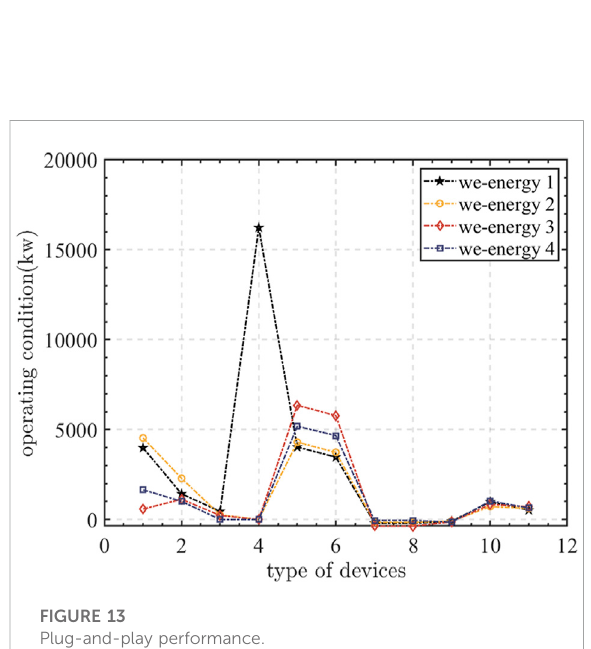
FIGURE 13 Plug-and-play performance.